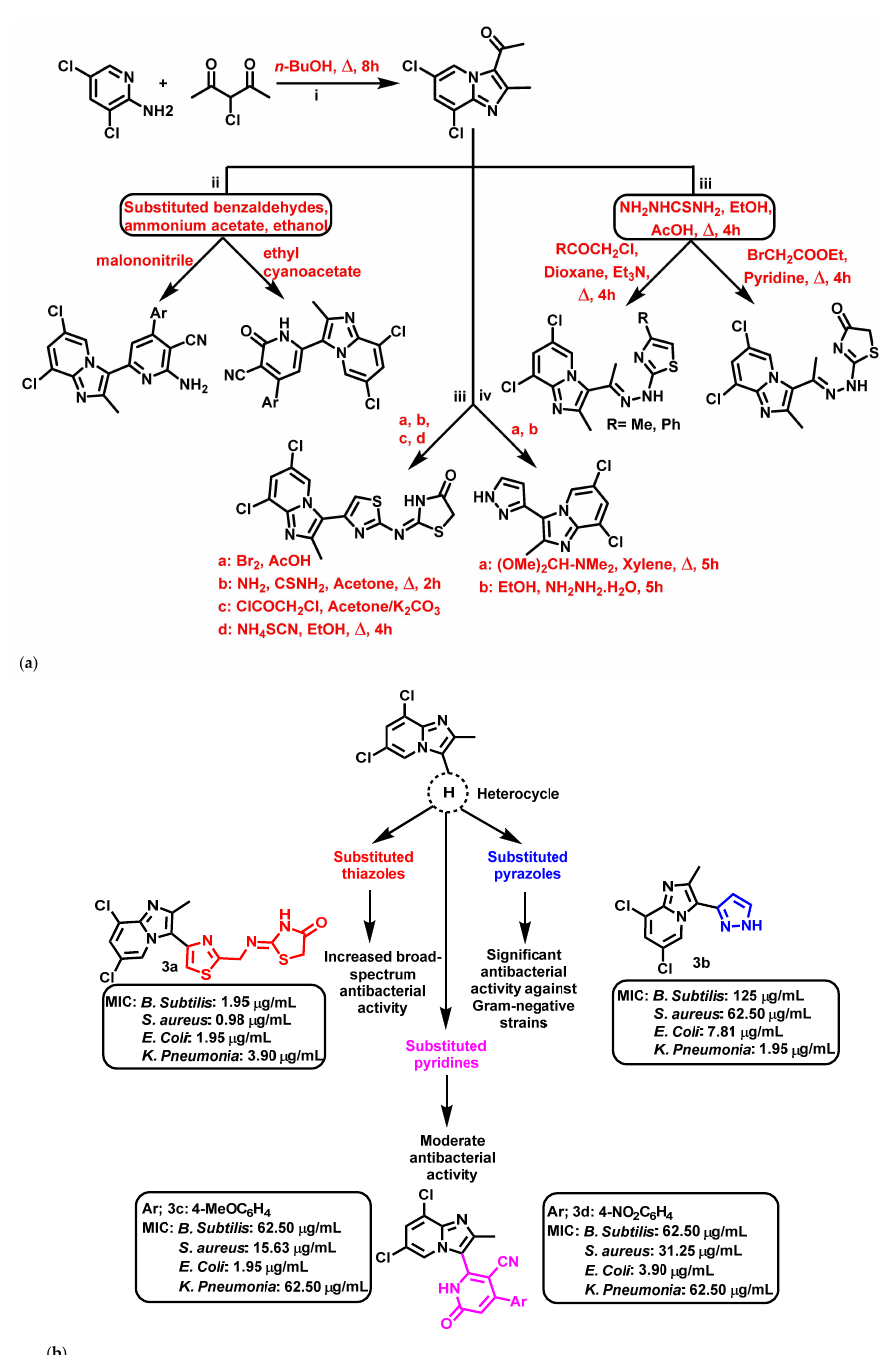
Figure 4. ( a ) Synthesis of (i) 3 ‐ acetyl ‐ 6,8 ‐ dichloro ‐ 2 ‐ methyl IZP, (ii) 6,8 ‐ dichloro ‐ 2 ‐ methylimidazo Figure 4. ( a ) Synthesis of (i) 3-acetyl-6,8-dichloro-2-methyl IZP, (ii) 6,8-dichloro-2-methylimidazo [1,2- [1,2 ‐ a]pyridinyl ‐ pyridine hybrids, (iii) 6,8 ‐ dichloro ‐ 2 ‐ methylimidazo [1,2 ‐ a]pyridinyl ‐ thiazole hy ‐ brids, and (iv) 3 ‐ )pyrazolyl) ‐ imidazo [1,2 ‐ a]pyridine hybrid. The signatures of these compounds a]pyridinyl-pyridine hybrids, (iii) 6,8-dichloro-2-methylimidazo [1,2-a]pyridinyl-thiazole hybrids, according to Althagafi et al., 2021 [58]. ( b ) Imidazopyridine ‐ based heterocycles, including pyri ‐ dine ‐ , pyrazole, and thiazole ‐ substituted systems. Signatures of compounds according to Althagafi and (iv) 3-)pyrazolyl)-imidazo [1,2-a]pyridine hybrid. The signatures of these compounds according et al., 2021 [58]. to Althagafi et al., 2021 [58]. ( b ) Imidazopyridine-based heterocycles, including pyridine-, pyrazole, Thakur et al., 2020 [59], reported that IZP conjoined pyran bis ‐ heterocyclic deriva ‐ and thiazole-substituted systems. Signatures of compounds according to Althagafi et al., 2021 [58]. tives are potent antibacterial agents. The derivatives were synthesized by ultrasound ‐ as ‐ sisted synthetic reactions combining multicomponent reactions, an eco ‐ friendly catalyst (gluconic acid aqueous solution), and a green solvent. The synthesis of an IZP ‐ pyran het ‐ In 2019, Ebenezer et al. [60] reported pyrazolo-IZP molecular conjugates as antibacte- erocycle involved malononitrile, cyclochexanedione, and substituted IZPs. The synthetic rial agents targeting cell wall synthesis. These derivatives were synthesized using a one- reaction mechanism encompassed Knoevenagel condensation and Michael reaction, fol ‐ pot, three-component tandem reaction employing CuSO 4 /Na-ascorbate and Cs 2 CO 3 as a lowed by cyclization and tautomerization (Figure 5a). Antibacterial studies showed sig ‐ nificant results for the synthesized compounds against E. coli , S. aureus , and Salmonella catalyst. Amongst the 12 synthesized derivatives, 5 (Figure 6) exhibited significant bacteri- typhi ( S. typhi ). Amongst the 11 synthesized derivatives, two molecules, i.e., 4a and 4b , cidal activity (zone of inhibition >9 mm) against Methicillin-Resistant Staphylococcus exhibited particularly strong activity against S. aureus ( 4a : 7.8 μ g/mL 4b : 31.25 μ g/mL) (Figure 5b). Thakur et al. noted that the presence of fluorine atoms at the para position of the phenyl ring of IZP increased the activity of these compounds against S. aureus . Further, the derivatives also yielded a pronounced (<10%) hemolytic effect, indicating that the compounds were benign to erythrocytes, as evidenced by hemolysis tests.